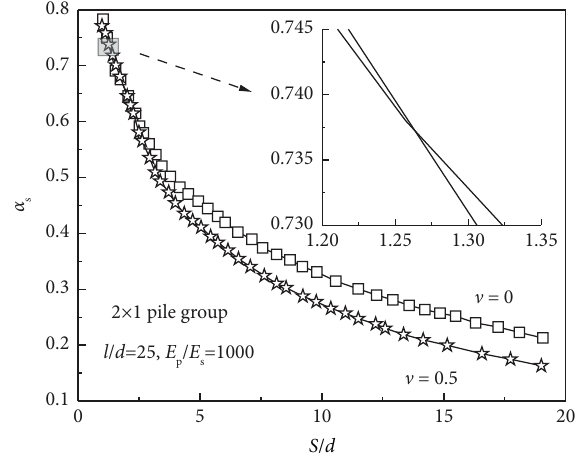
Figure 12: Infuence of slenderness ratios l / d on interaction factor α s .